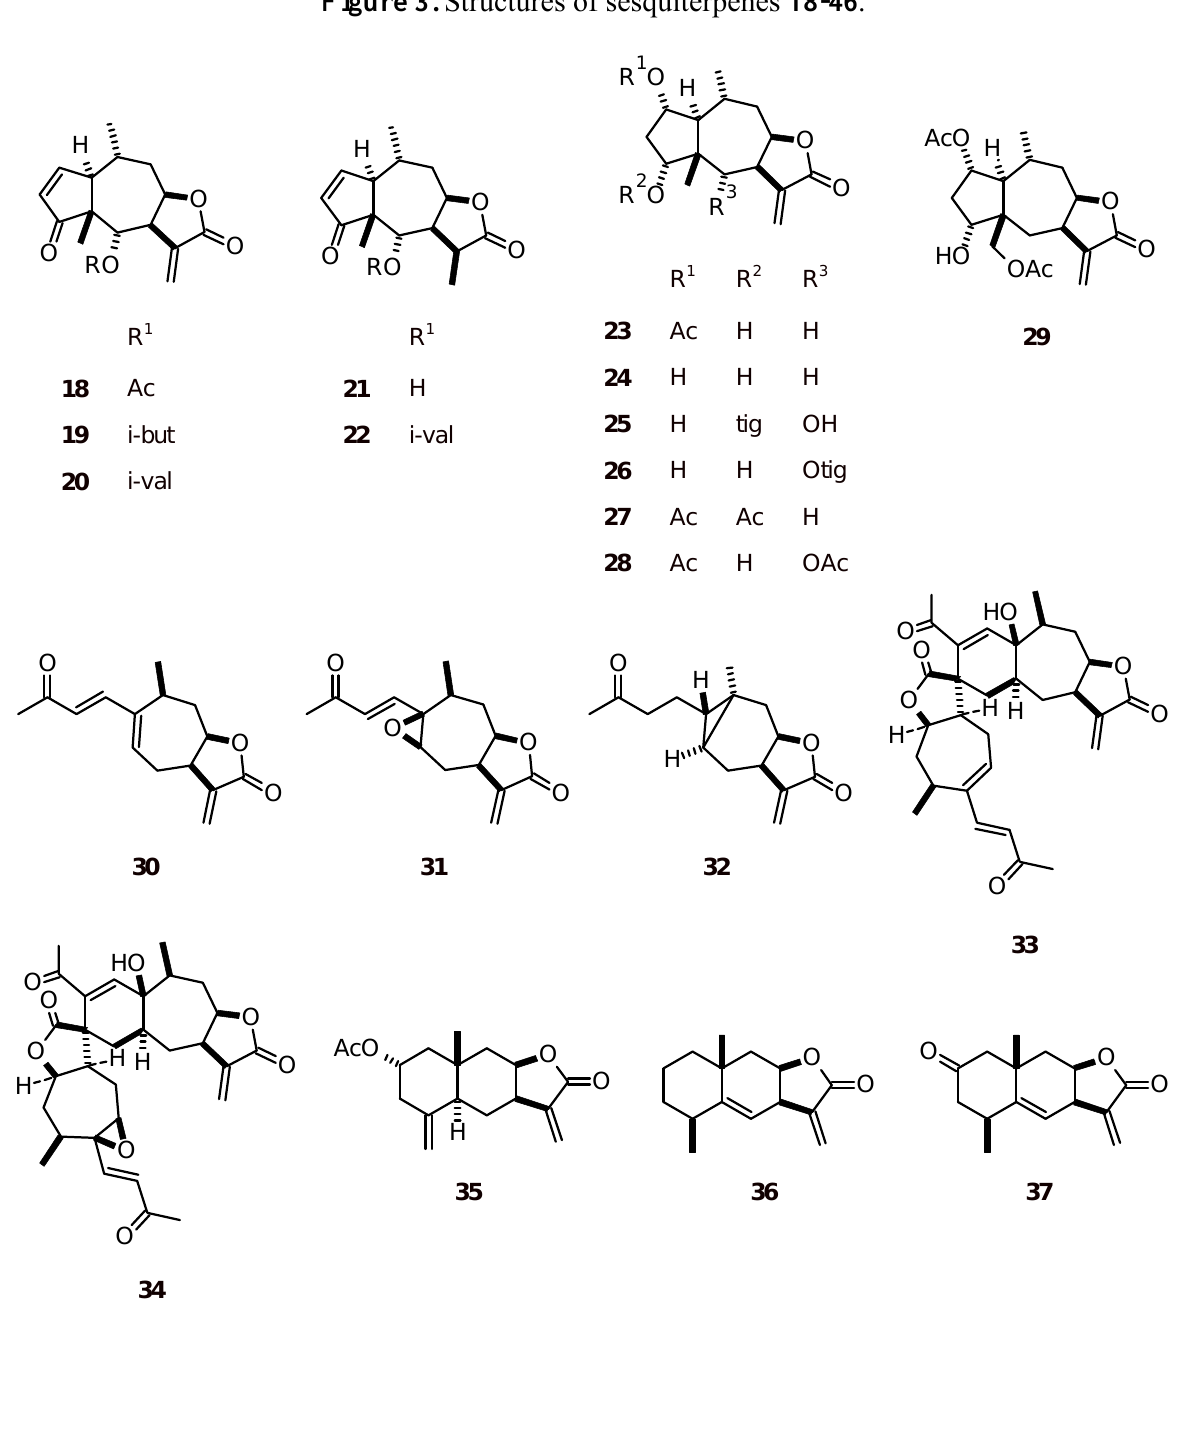
Figure 3. Structures of sesquiterpenes 18-46